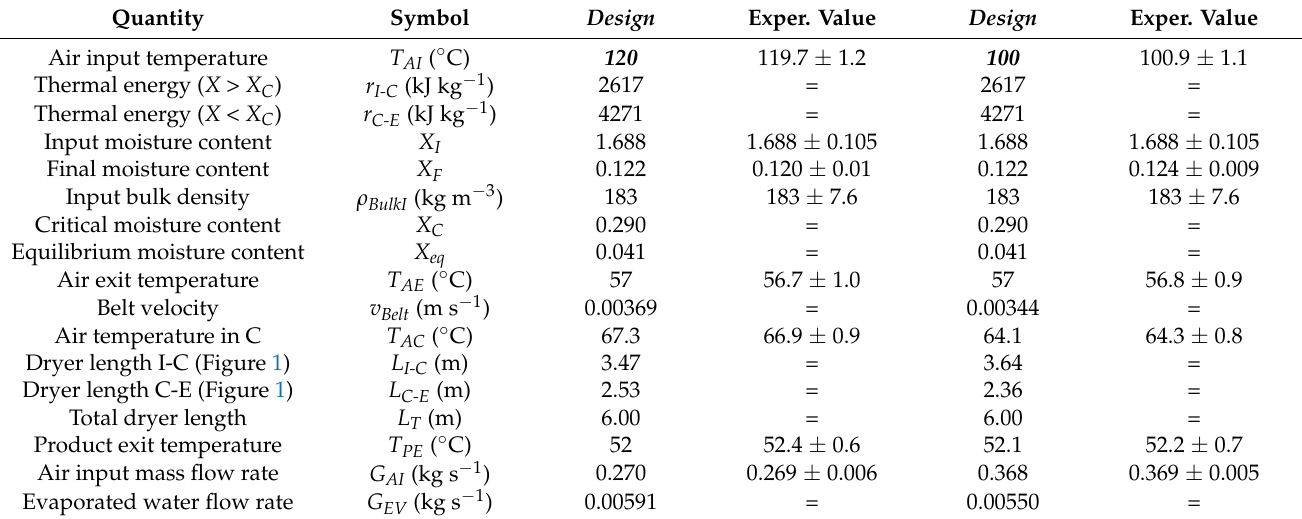
Table 4. Results of the validation of the mathematical modeling and design